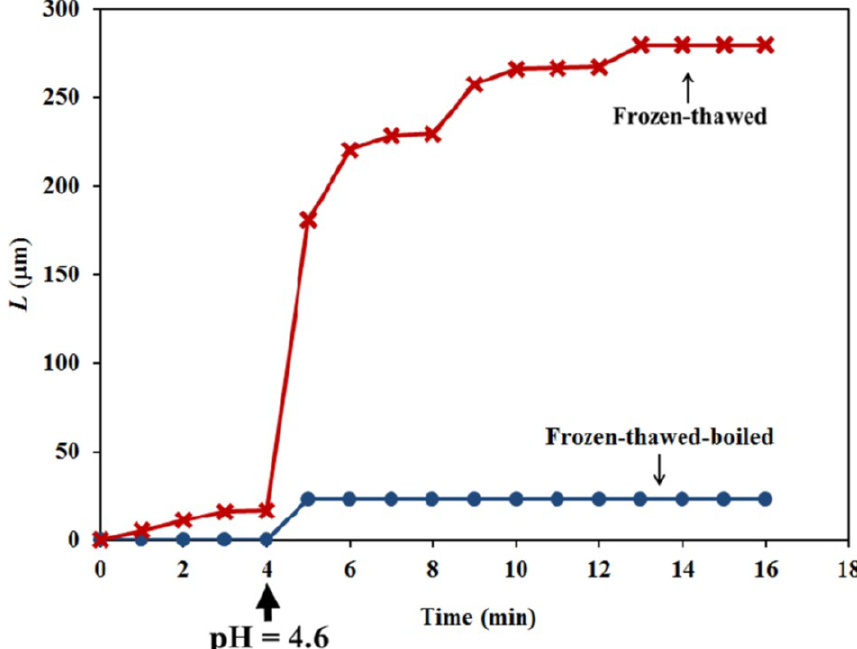
Figure 7. The average change in extension versus time of 15 different frozen-thawed walls is shown (red curve with X data points and labeled “Frozen-thawed”). The average change in extension versus time of eight frozen-thawed-boiled walls (blue curve with • data points and labeled “Frozen-thawed-boiled”) is shown.